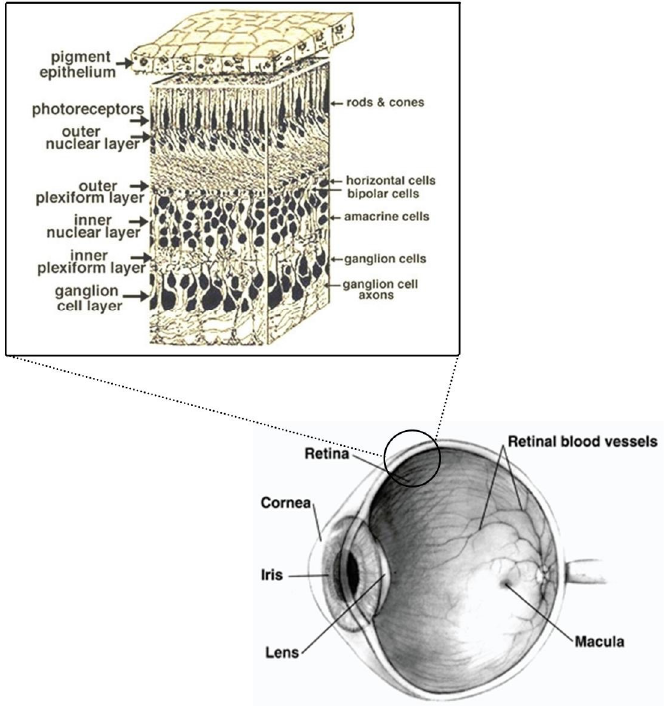
Figure 1. Eye and retina section scheme adapted from Webvision, (http://webvision.med.utah.edu/) and NIH National Eye Institute.